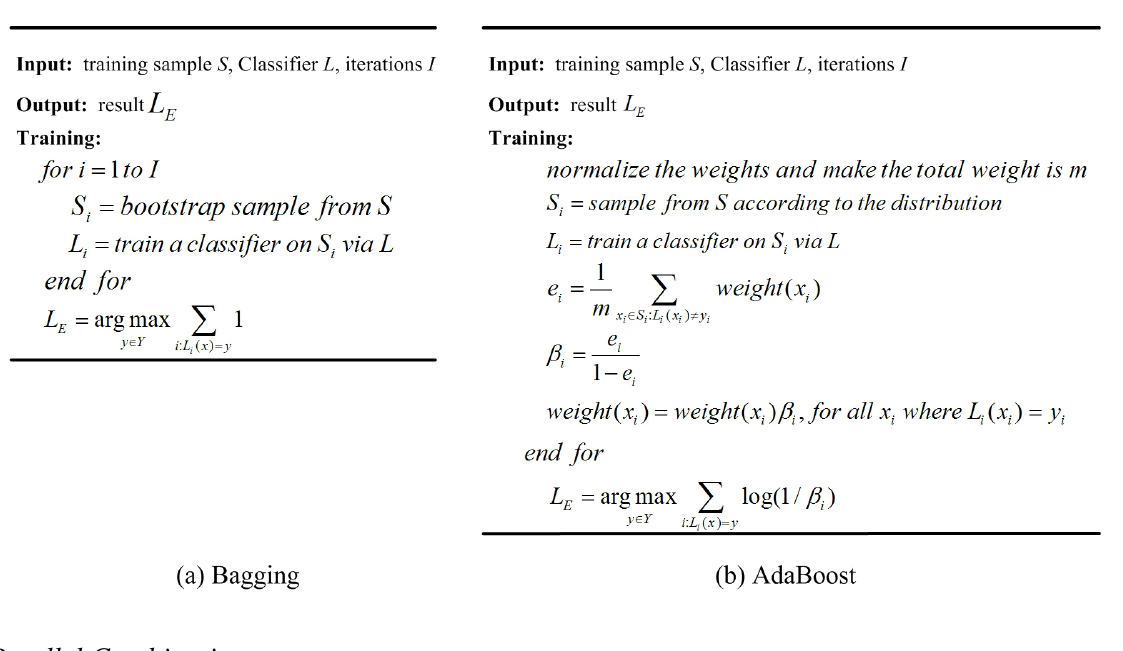
Figure 2. The pseudo-code of Bagging and AdaBoost